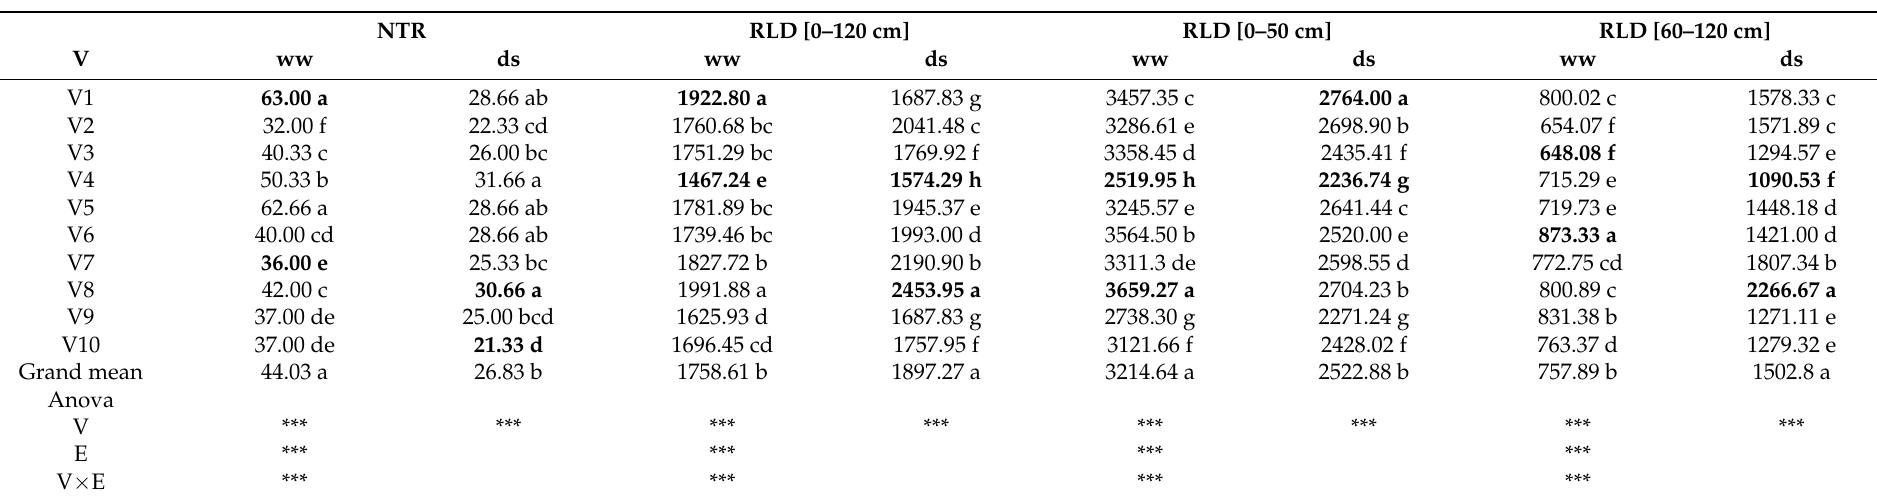
Table 6. Average performance and statistical parameters of roots length density (RLD) and number of total roots (NTR) traits of sorghum varieties under well-watered and drought stress